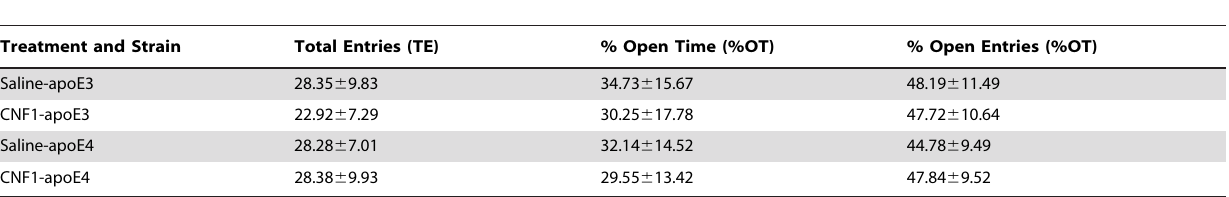
Table 1. Effect of acute saline or CNF1 icv with regards to Elevated Plus Maze (EPM) behavior.